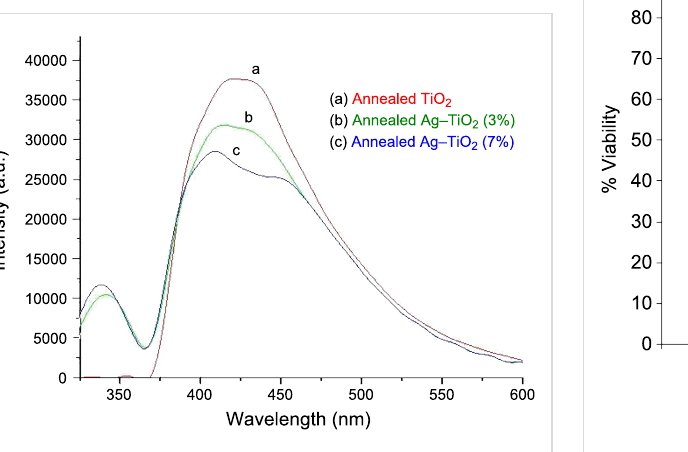
Figure 5: Photoluminescence spectra of annealed TiO 2 (a) and 3% and 7% Ag-doped TiO 2 nanoparticles (b,c).